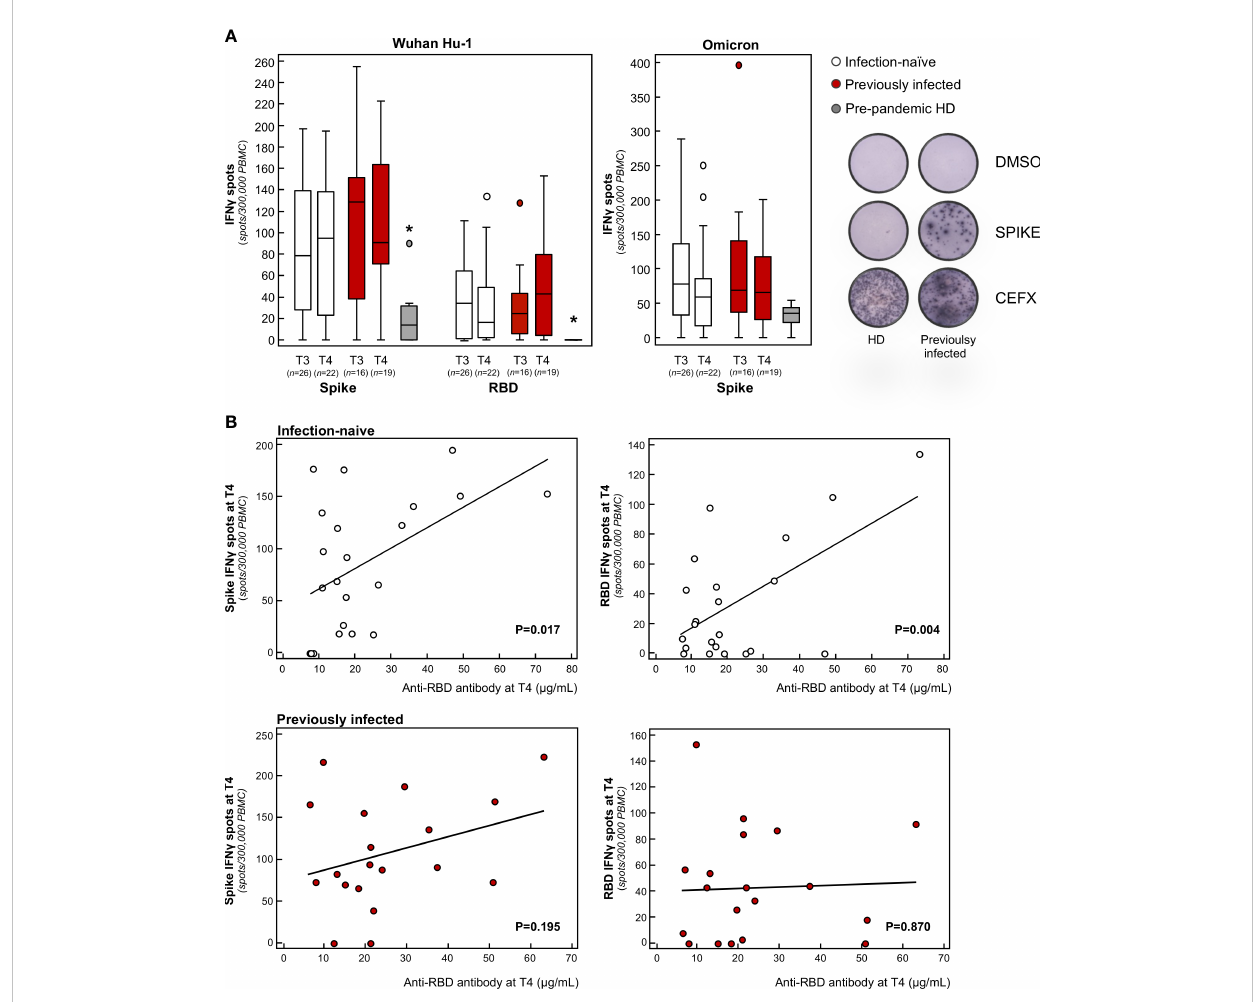
FIGURE 3 Analysis of effector T cell response in infection-naïve and previously infected vaccine recipients over time. (A) Frequency of IFN g producing T cells in response to peptide pools of the spike and RBD protein of the Wuhan Hu-1 SARS-CoV-2 and in response to the B.1.1.529.1 (Omicron) spike protein in infection-naïve and previously infected subjects at 9 months after primary vaccination (T3) and 3 months after the booster dose (T4), as well as in pre-pandemic healthy donors (HD). Representative ELISPOT wells are shown on the right. Horizontal lines indicate median values; * p-value <0.005 vs of infection-naïve and previously infected subjects at T3 and T4. (B) Correlation of anti-RBD antibody levels with the frequency of spike-speci fi c (left panels) or RBD-speci fi c (right panels) IFN g producing T cells at T4 in the two study groups. The sample size ( n ) for all T cell analyses is indicated in brackets in panel (A)